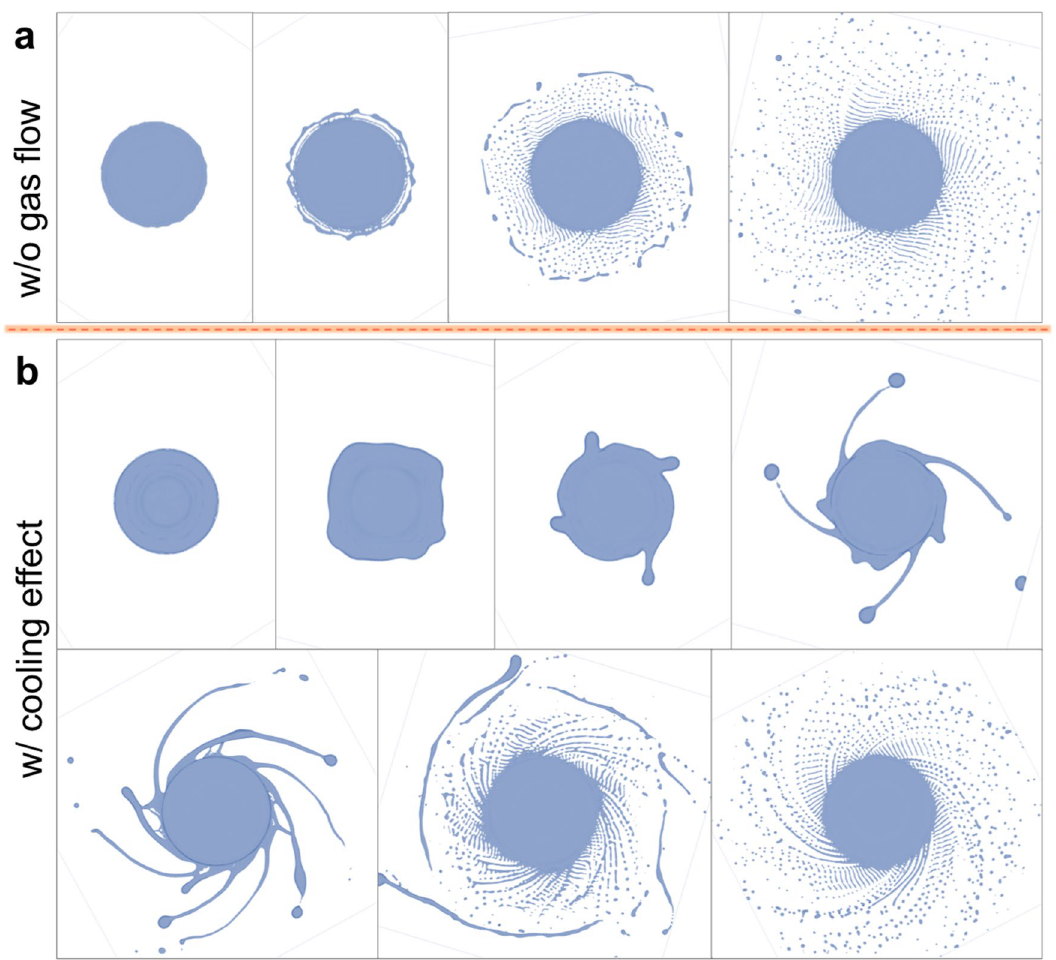
Figure 7. Initial stage of the centrifugal granulation process in the CtFD simulation cases ( a ) without gas blast and ( b ) with cooling